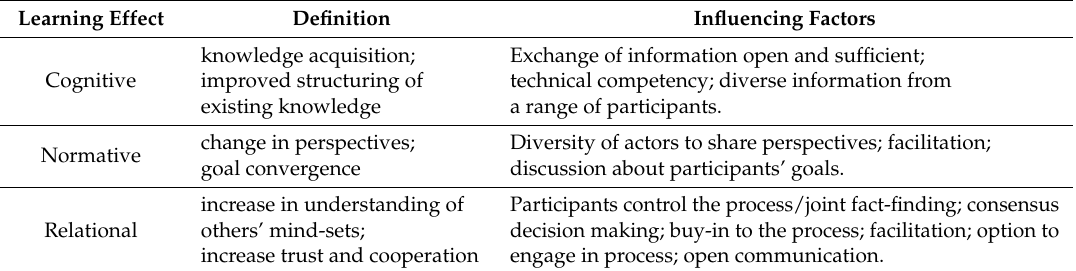
Table 1. A typology of learning with definitions and factors from the literature said to enhance the different learning